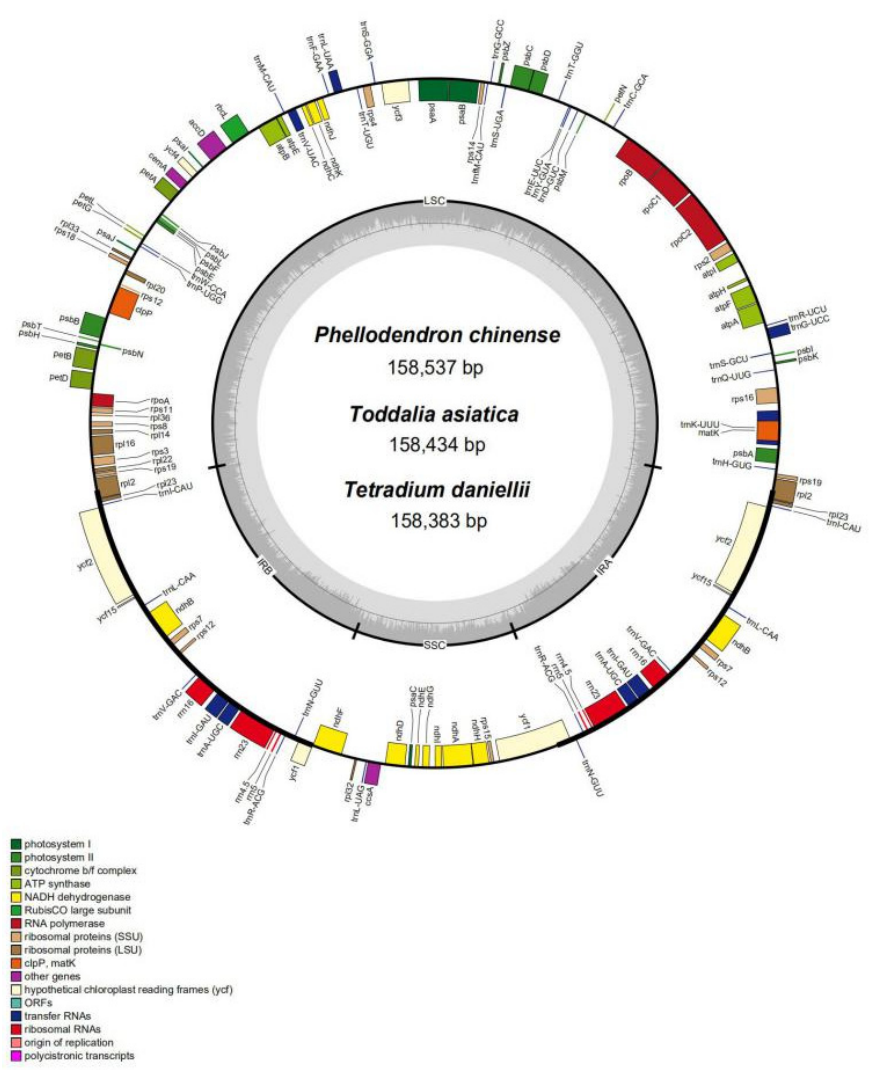
Figure 1. Gene map of three Rutaceae species plastomes. Genes shown inside the inner circle are transcribed counterclockwise and those outside are transcribed clockwise. Genes belonging to different functional groups are colour-coded. Darker grey in the inner circle corresponds to the GC content of the chloroplast genome. IRs, two inverted repeats; LSC, the large single copy; SSC, the small single copy.